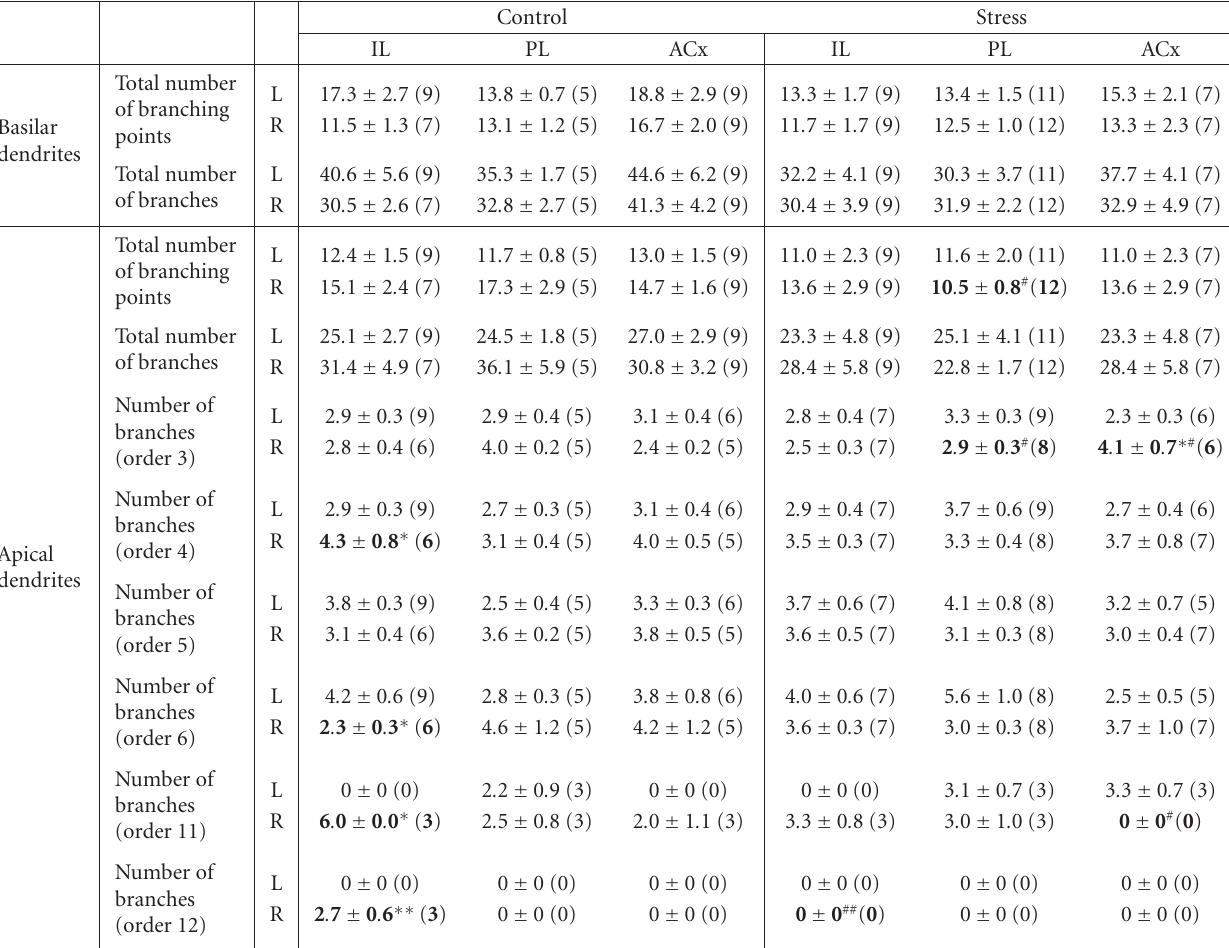
Table 2: Number of branching points and branches in basilar and apical dendrites on pyramidal neurons in PFC subareas.